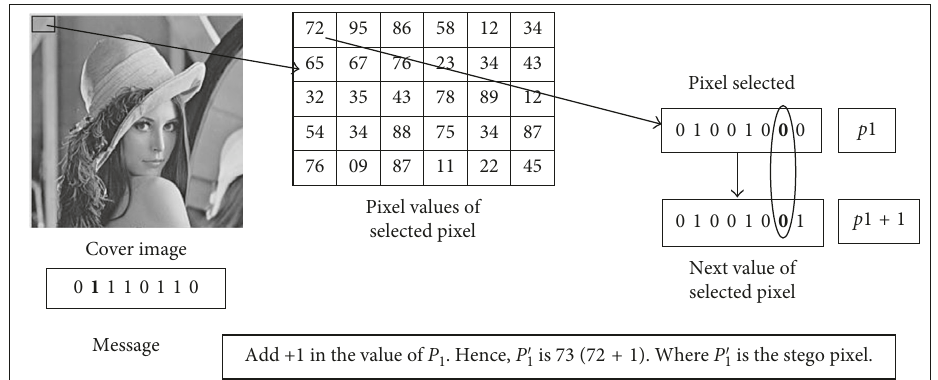
Figure 2: Diagram of the proposed method.